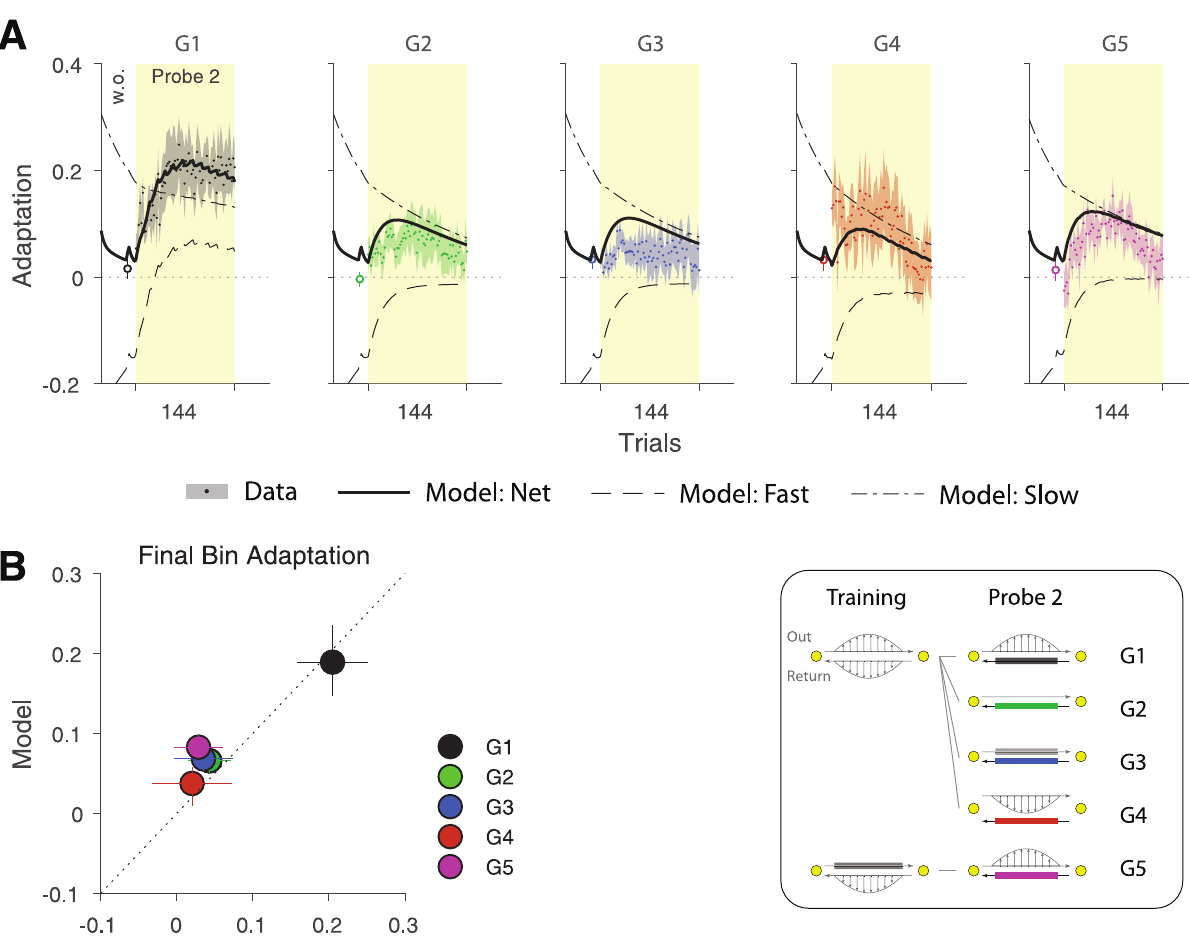
Fig 7. Model fits for Probe2. A . The net model output (solid black line) as well as the fast (dashed line) and slow (dash-dotted line) adaptive states shown for the Return trials of Probe2 for all groups. At the end of the washout period prior to Probe2, the fast and slow processes are at opposite sides, predicting a rebound during Probe2 for all groups. The extent of this rebound is larger for G1, due to greater increase of the fast process and slower decay of the slow process compared to other groups. B . Adaptation in the final 12 trials of Probe2 (i.e., final bin as in Fig 3C). The model prediction is plotted against the data. The error bars in the horizontal dimension represent the standard error of the mean across subjects, and the error bars for the vertical dimension are the 95% confidence intervals from bootstrapping.